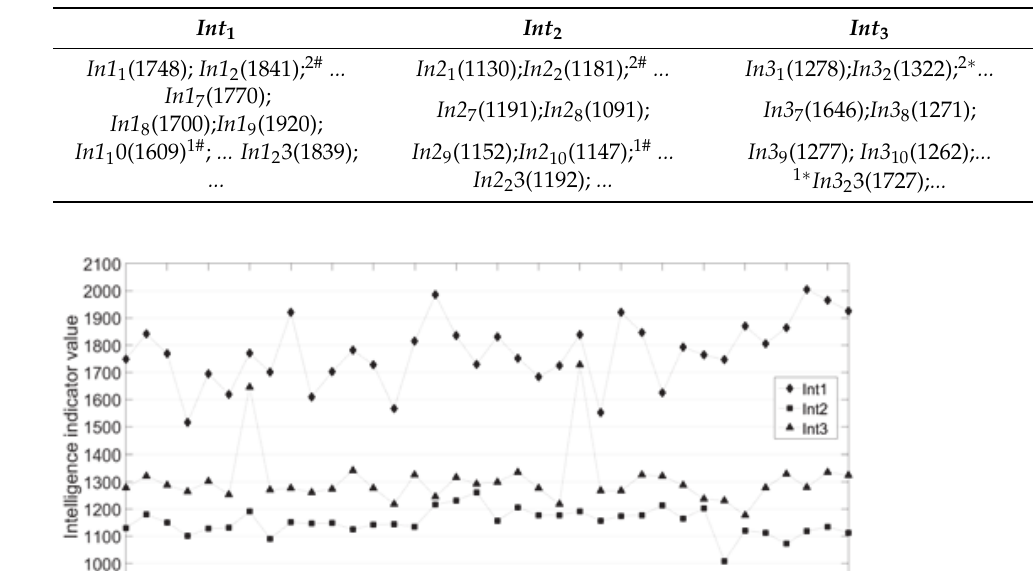
Table 3. Intelligence indicators for Coop 1 / Int 1 , Coop 2 / Int 2 , and Coop 3 / Int 3 .